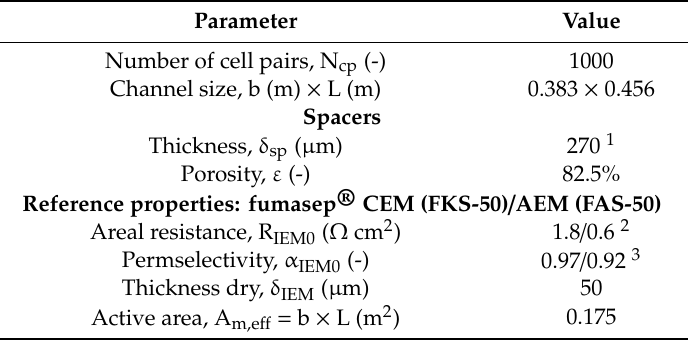
Table 2. Parameters of the commercial RED stack (Fumatech GmbH ® ,